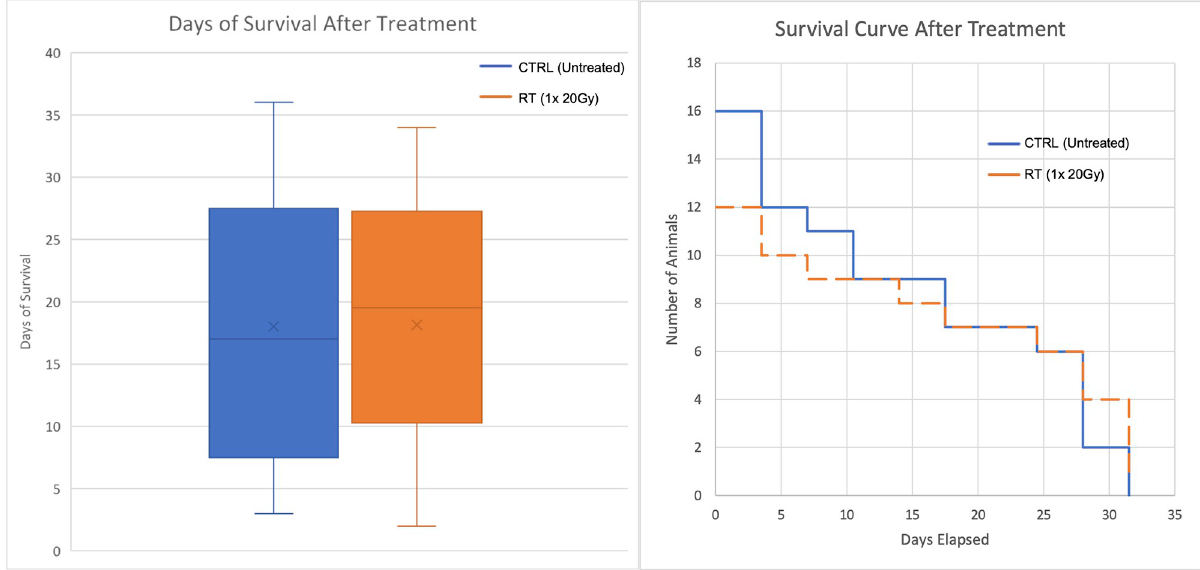
Fig 8. Plots featuring survival of CTRL and RT animals. Box and whisker plot showing animal survival after RT (left), n = 27, comparing survival of untreated animals (blue), n = 14, and animals given a single dose of 20 Gy (orange), n = 13. Kaplan-Meier survival curve showing the rate of animal mortality throughout the period after RT (right), n = 28, featuring survival of untreated animals (blue), n = 16, and animals given a single dose of 20 Gy (orange), n = 12. Like tumor size response, both left and right lung animals had similar survival outcome and were grouped together for analysis. The same treatment regimen is applied to animals in Fig 5 and the current